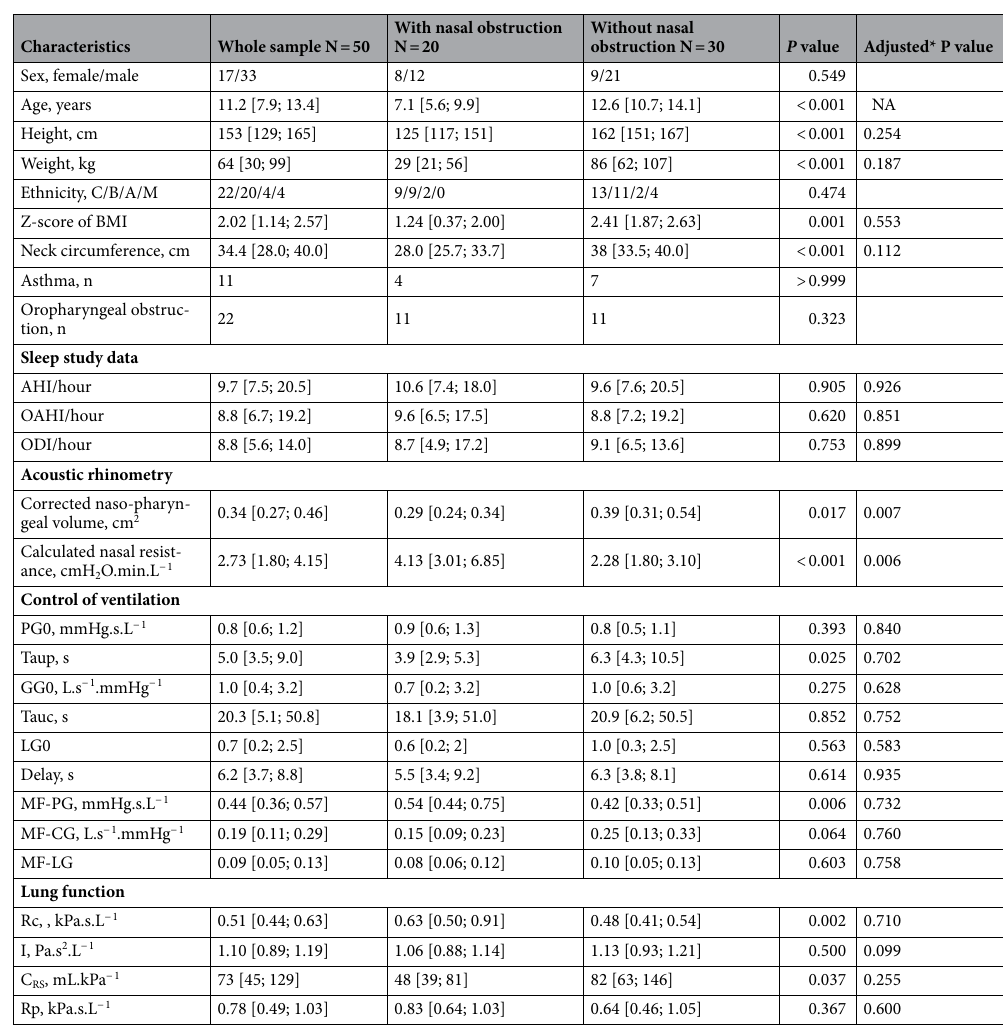
Table 1. Clinical characteristics, control of ventilation and lung function parameters in the whole sample and according to the presence of nasal obstruction. Ethnicities are Caucasian/African/Asian/Mixed. P value stands for the comparison of groups with and without nasal obstruction. *Statistical tests were adjusted for the presence of oropharyngeal obstruction and age for ventilatory control parameters and only for age for all other parameters (adjusted p